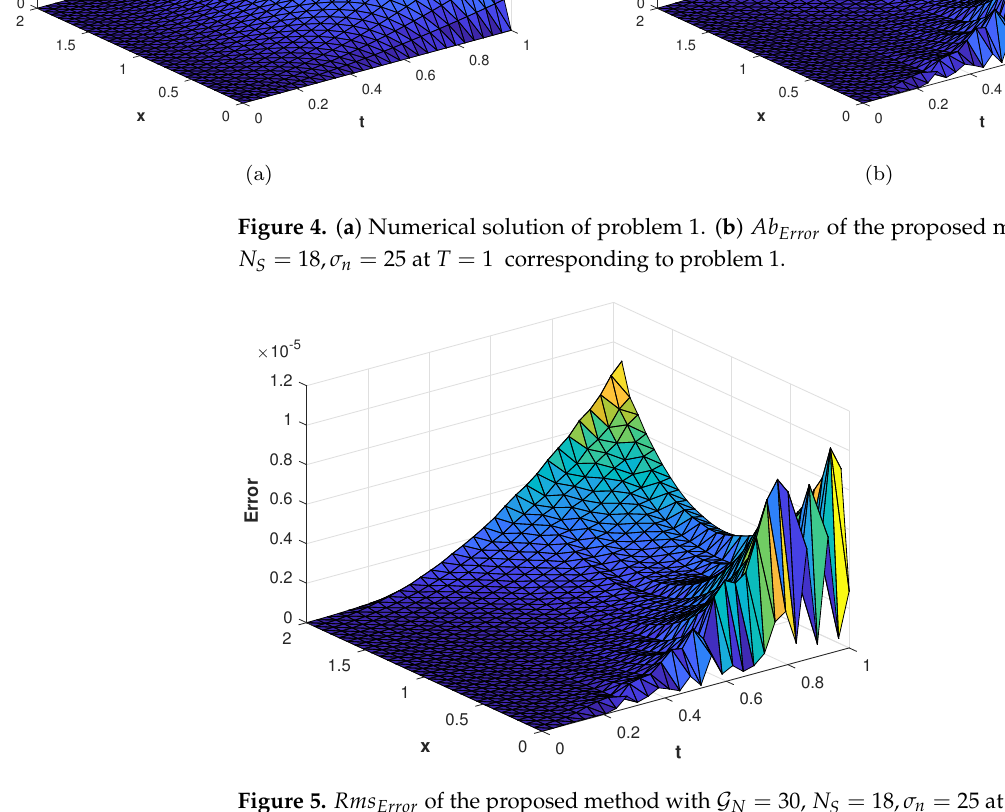
= 30 , N S = 18 , σ n = 25 at T = 1 corresponding to G N = 30, N S = 18, σ n = 25 at T = 1 corresponding G N = 30 , N S = 18 ,σ n = 25 at T = 1 corresponding to G N